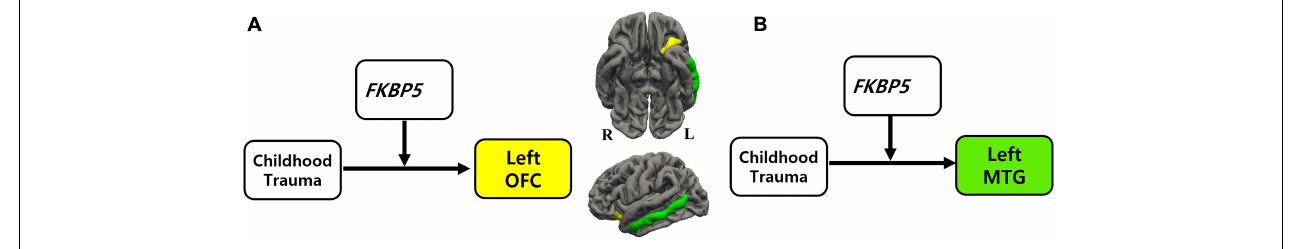
FIGURE 1 | The moderation effect of FKBP5 variants on the relationship between childhood trauma and brain volume. ( a ) Survived six moderation effects of FKBP5 variants (including rs3800373, rs1360780, rs4713916, rs4713919, rs6902321, and rs3798345) after FDR correction (alpha < 0.10) in the left OFC. ( b ) Survived four